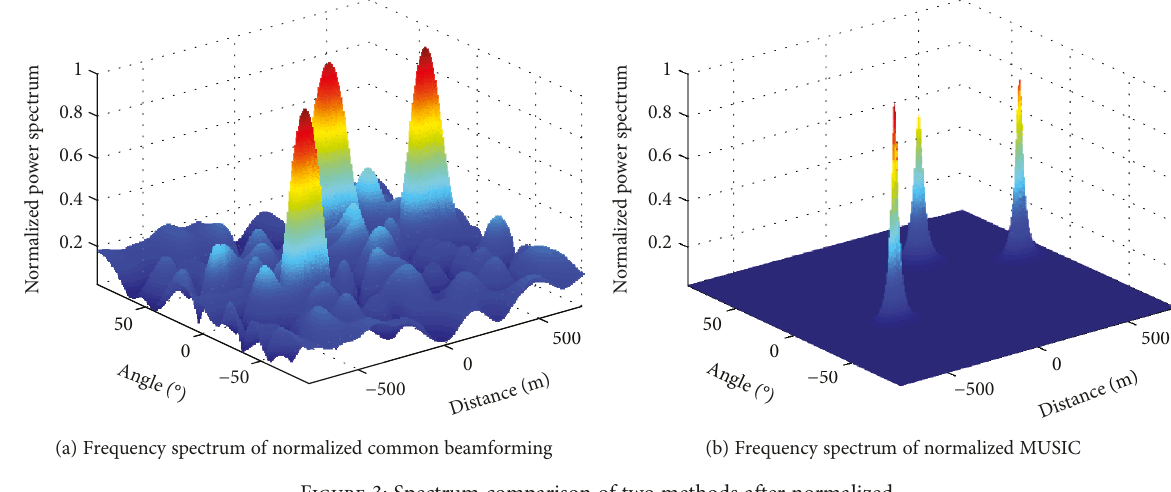
Figure 3: Spectrum comparison of two methods after normalized.